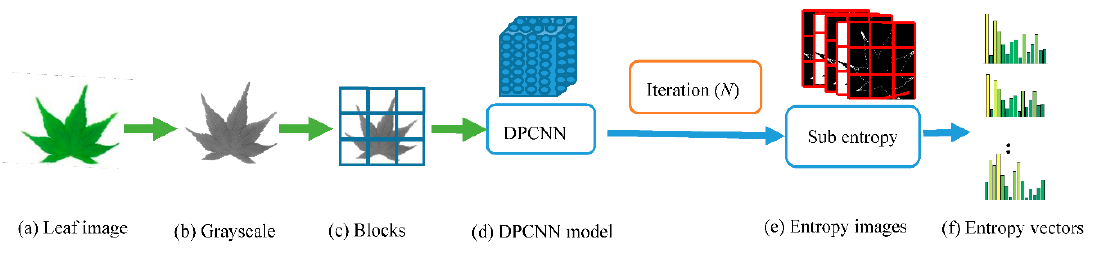
Figure 4. Flow of getting entropy vector. Figure 5. Acquisition of image features using BOF_DPCNN: ( a ) entropy vectors obtained by DPCNN model; ( b ) codebook obtained by learning features; ( c ) the LLC coding; and ( d ) SPM for pooling.